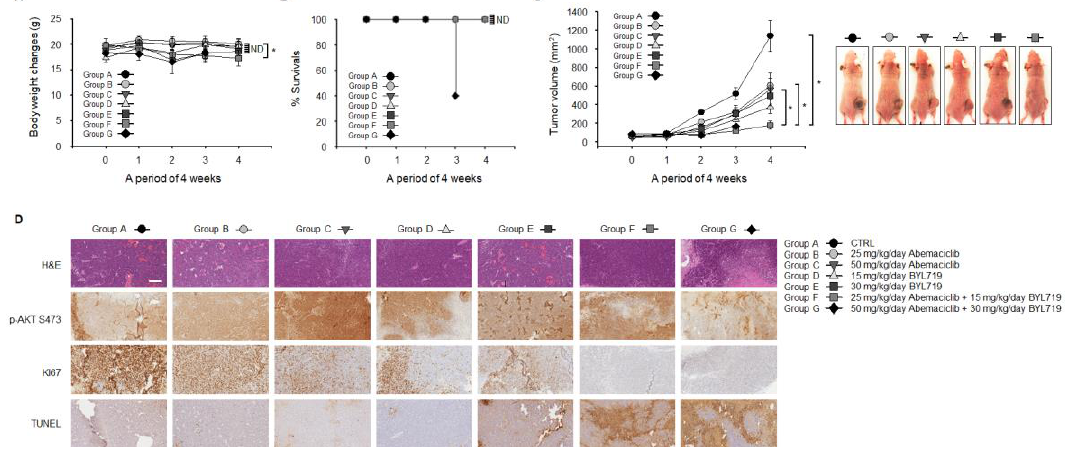
Figure 5. Enhanced anti-tumor efficacy of abemaciclib combined with BYL719 in colon cancer xenografts. ( A ) Athymic nude mice bearing SNU-C4 xenografts were administered with vehicle, abemaciclib (25 or 50 mg/kg/day) alone, BYL719 (15 or 30 mg/kg/day) alone, or the combination of abemaciclib and BYL719. ( B ) Body weight and survival were evaluated every seven days. ( C ) The overall anti-tumor efficacy of drugs was measured by tumor volume every seven days. Error bars represent the standard error of the mean. ( D ) Formalin-fixed paraffin-embedded tumor sections were stained with H&E and for p-AKT S473, Ki67, and TUNEL. Scale bar: 300 μ m.